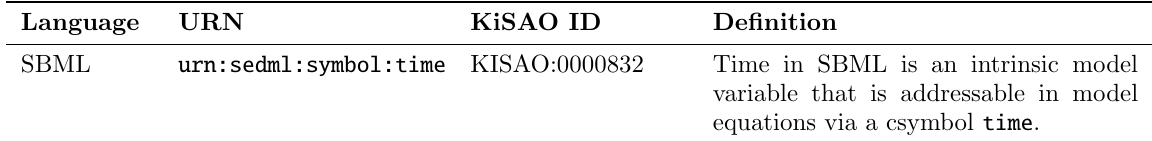
Table 3.1: The single predefined symbol in SED-ML. For Level 1 Version 4, KiSAO IDs are used instead, though ‘time’ is still allowed for backwards compatibility. The latest list of KiSAO terms is available from https://github.com/SED-ML/KiSAO